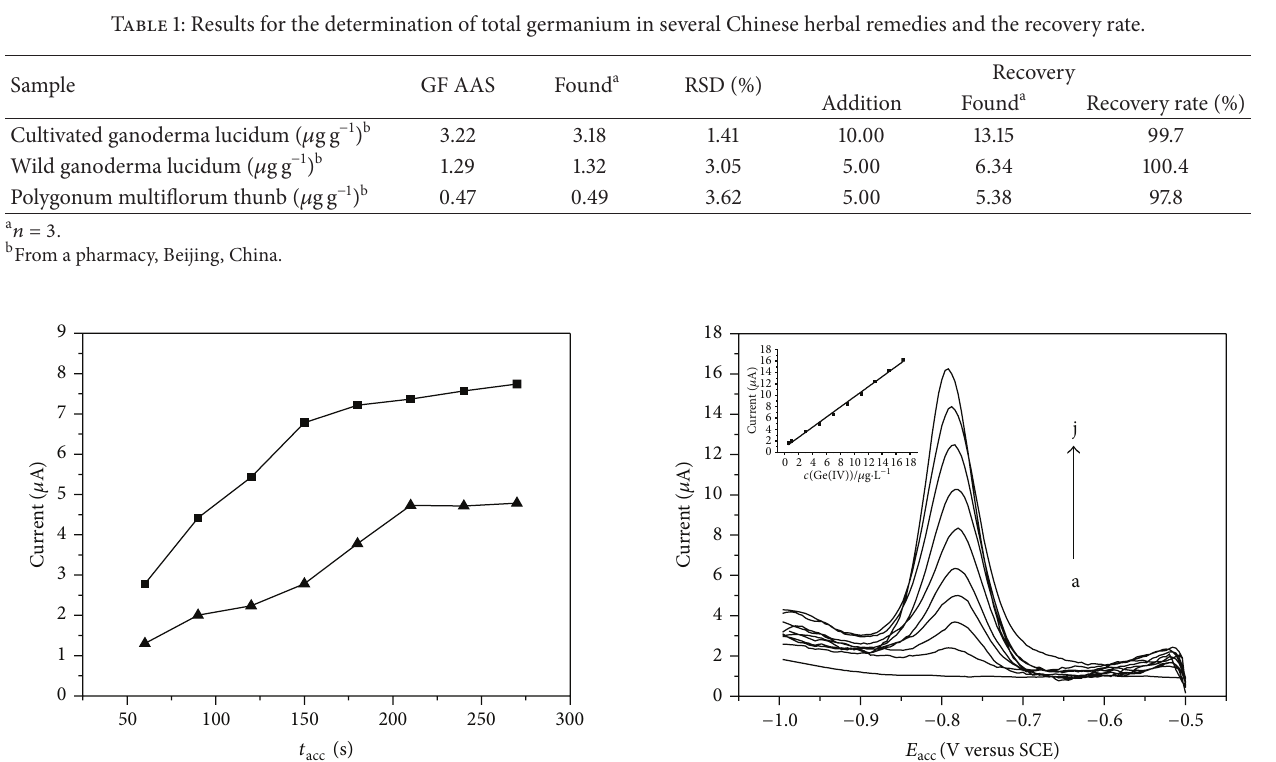
Figure 8: Adsorptive stripping curves of Ge(IV) concentrations from 0 to 17 𝜇 gL −1 (a–j) (a: 0, b: 0.5, and c–j: 1–17 (in the step of 2 𝜇 g L −1 )) obtained at the bismuth film electrode. Pyrogallol concentration 1.3 × 10 −3 molL −1 . Other conditions as in Figure